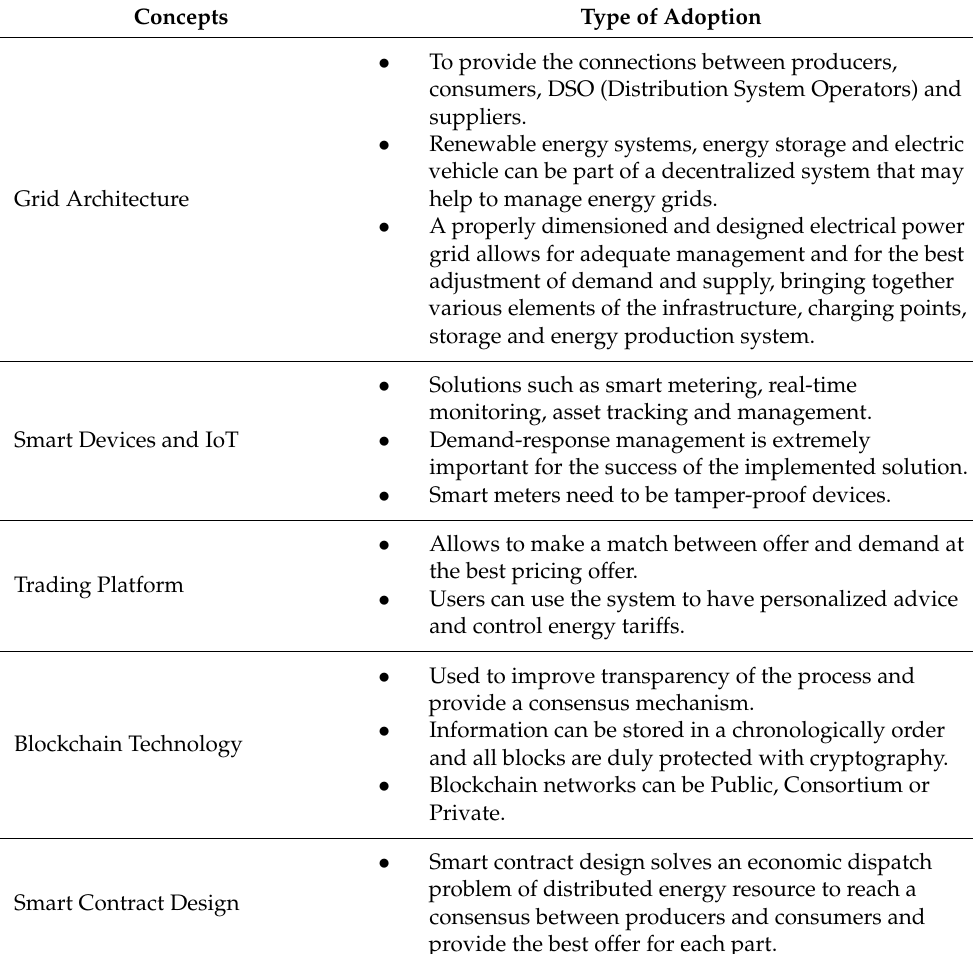
Table 7. Energy decentralization